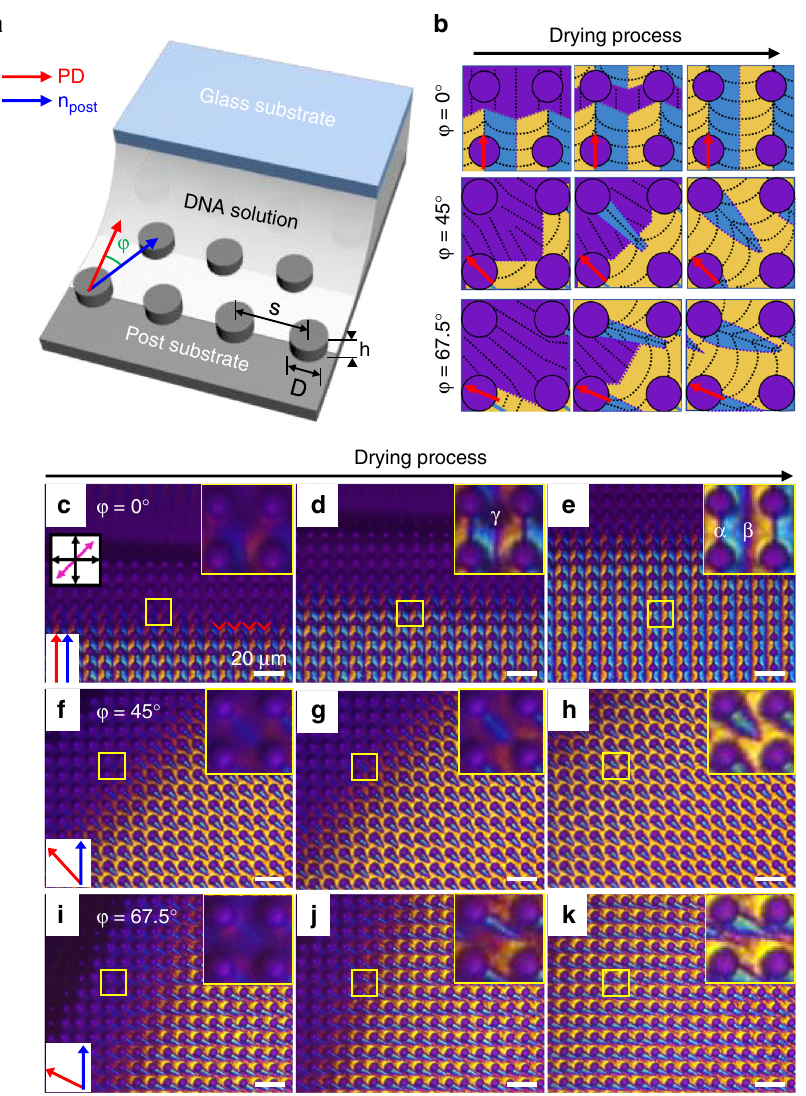
Fig. 2 Real-time observation of fabrication process depending on the angle. a Schematic illustration of how the experiments were performed using the shearing process, and the dimensions of the microposts ( s = 10 μ m, D = 5 μ m and h = 5 μ m). b Schematic sketches of the sequential changes in DNA chain-arrangement during the evaporation of water. c – e At φ = 0°, sequential growing microstructures of DNA fi lm can be observed as the water evaporates. Similar but different structures can be generated f – h at φ = 45°, and i – k at φ = 67.5°. Enlarged images show the detailed orientation of the DNA chains. Yellow colour means the DNA chains are aligned parallel to the optical axis of the full wave plate (pink arrow in c ), whereas the blue domains appear when the n DNA is perpendicular to the pink arrow. All scales are 10 μ